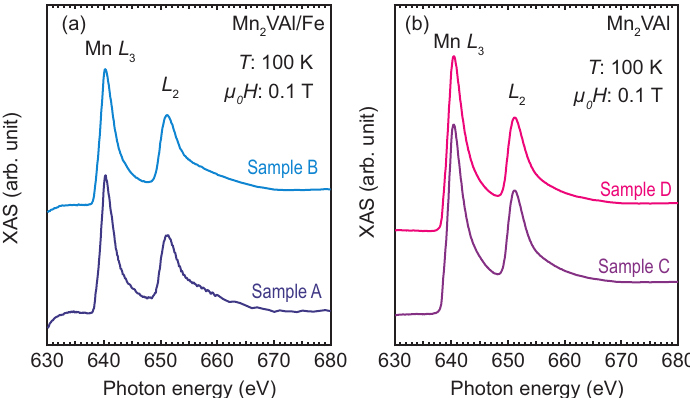
Figure 5. Soft X-ray absorption, XAS spectra around Mn L 3,2 -absorption edges for ( a ) Mn 2 VAl/Fe layered and ( b ) Mn 2 VAl single-layer films. All spectra were measured at 100 K with an applied magnetic field ( H ) of 0.1 T. The XAS spectra in the panel ( a ) is expanded by a factor of 2.5 with respect to those in the panel ( b